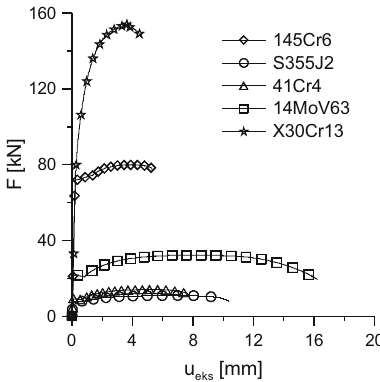
Figure 1: Experimental “ force – displacement of the extensometer ” curves recorded in the laboratory – P = f ( u eks )